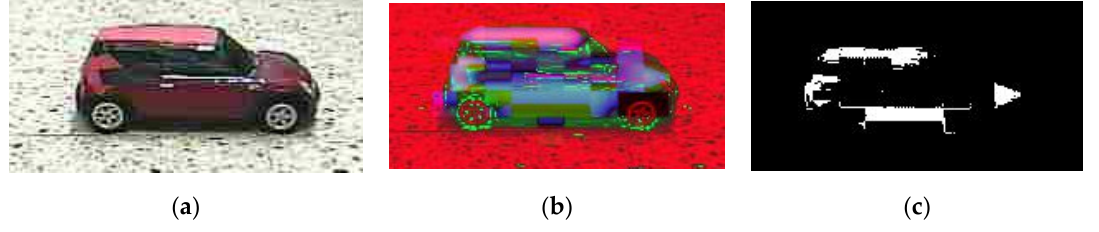
Figure 1. ( a ) Original red/green/blue (RGB) image; ( b ) hue/saturation/value (HSV) space image; ( c ) Binary image of the HSV space.